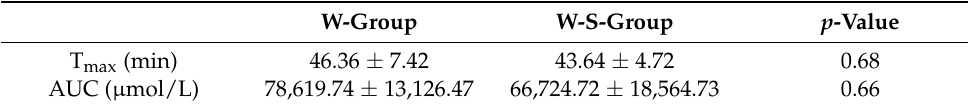
Figure 1. Total amino acid concentrations of P-, S-, W-, and W-S-groups. Each group was measured plasma total amino acid concentrations after ingested test solutions (P: water, S: sucrose, W: whey, and W-S: whey plus sucrose). All values are presented as mean ± SEM. n = 11 per group. Means without a common letter at same time point are statistically different ( p < 0.05, two-way repeated measures ANOVA followed by Tukey’s multiple comparisons). Table 1 . T max and AUC of the whey and whey and sucrose groups.